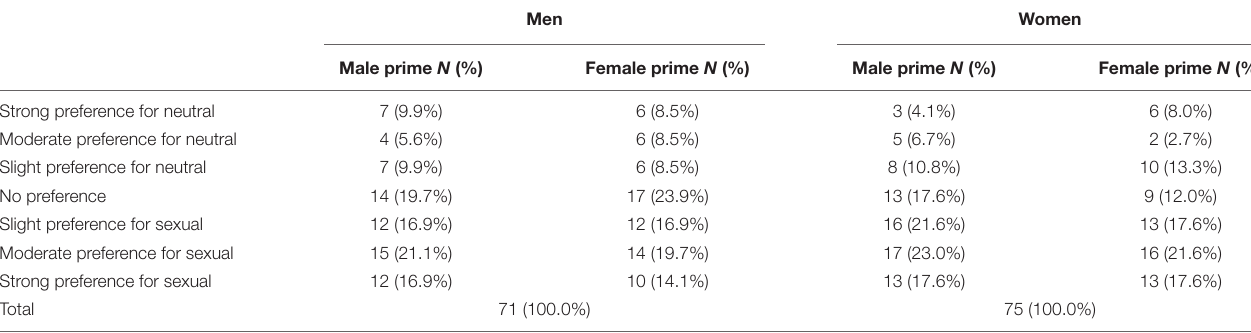
TABLE 1 | Descriptive information for the magnitude of men’s and women’s D